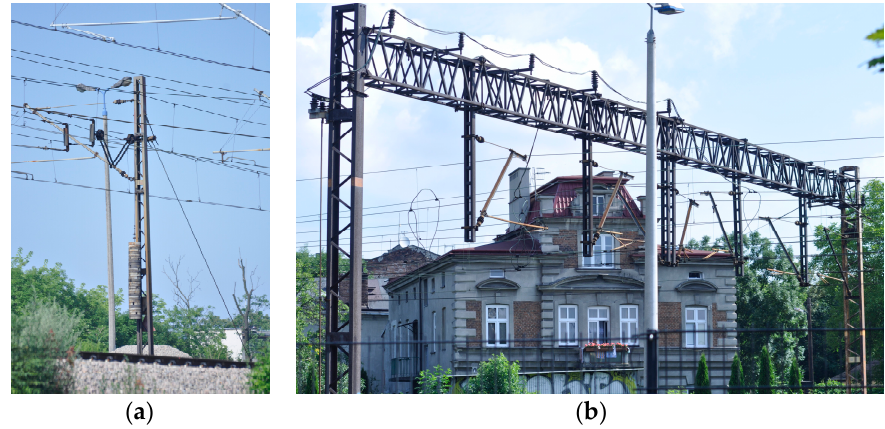
Figure 3. Catenary system support structures. Single solution ( a ) and multi-track solution, portal structure ( b ).